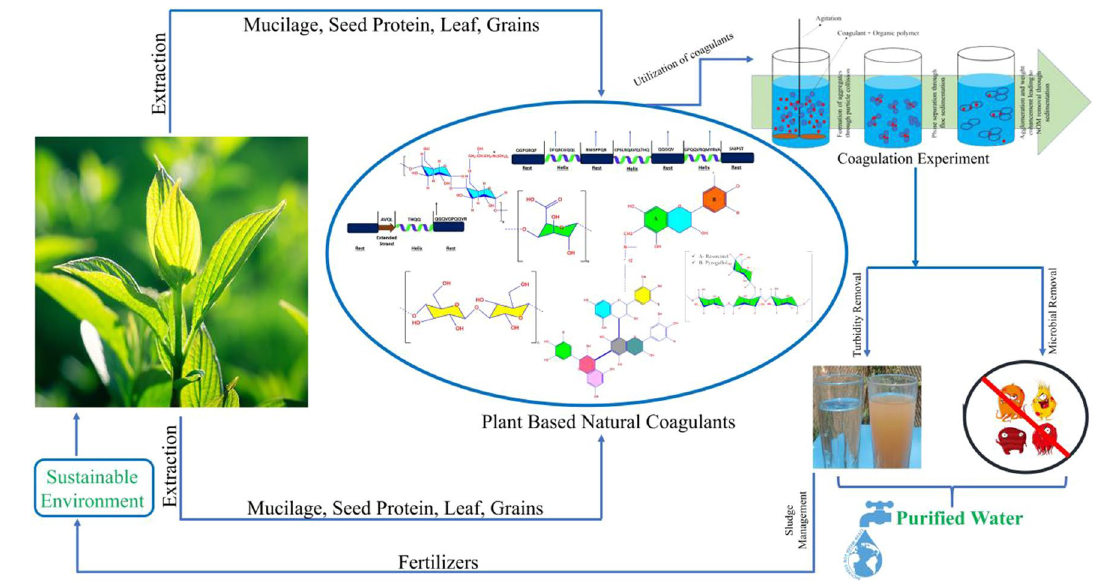
Fig. 3 Flow diagram for the current